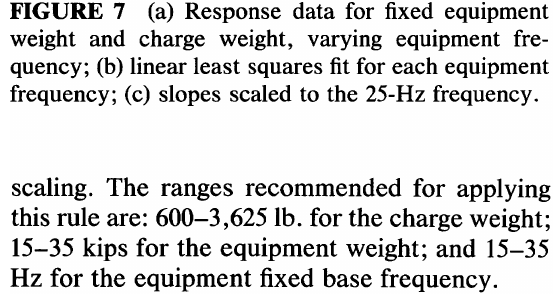
FIGURE 8 (a) Original hull model and equipment; (b) linearly scaled hull and equipment; (c) linearly scaled hull, original